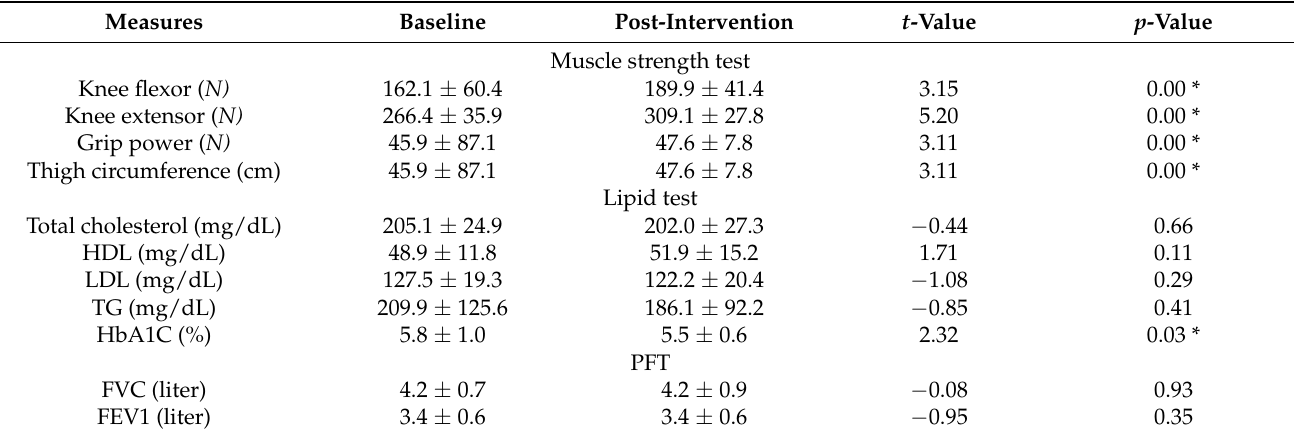
Table 3. Changes in clinical data (n = 14).